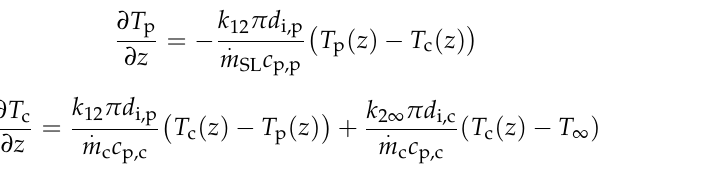
Figure A3. Temperature profile for four CUs in counter-current flow for the experiments seed 125–180 1 and 2.